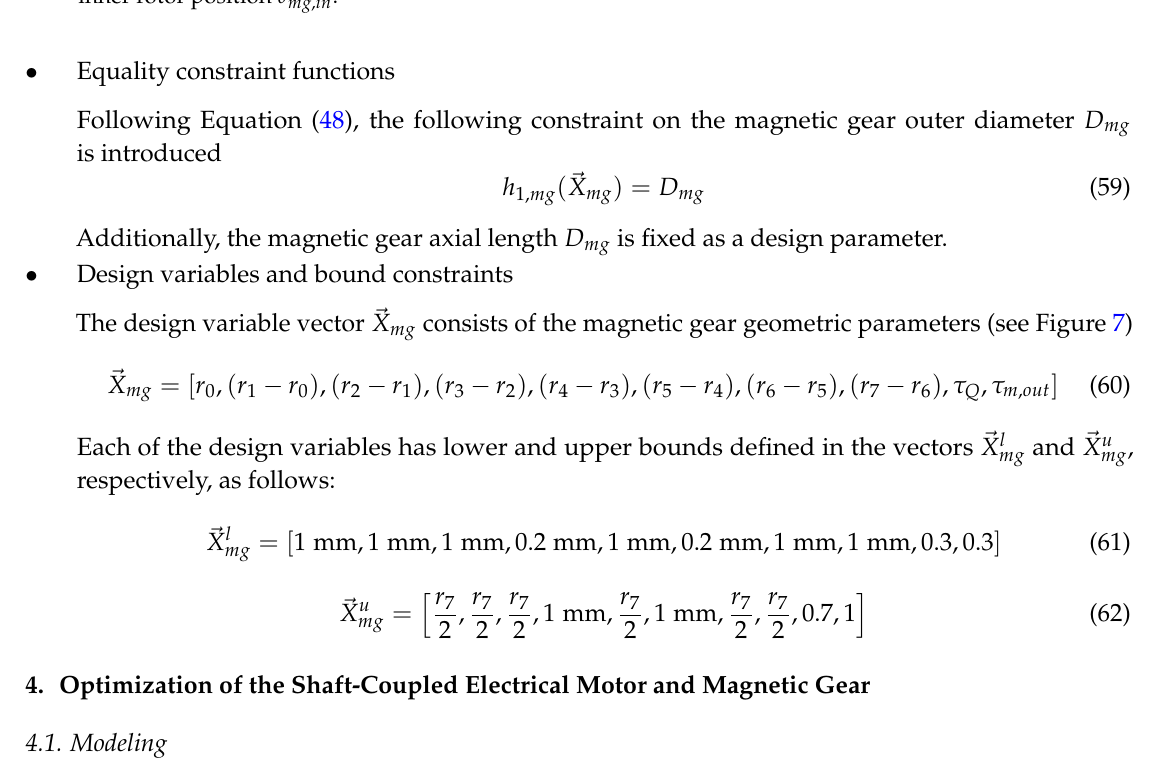
Figure 17. Estimated magnetic flux densities in the stator core B SC and pole-pieces B PP as a function of inner rotor position θ mg , in